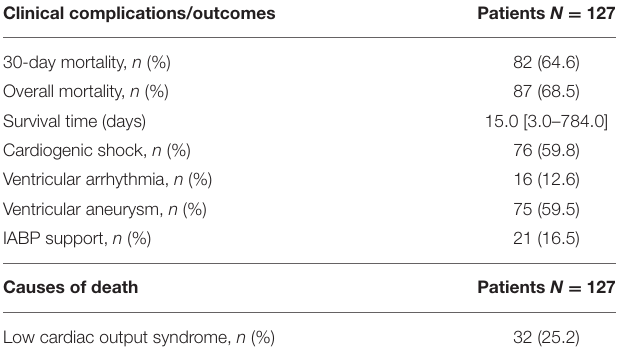
TABLE 2 | Clinical complications, causes of death, and outcomes of patients with VSR. Clinical complications/outcomes Patients N =